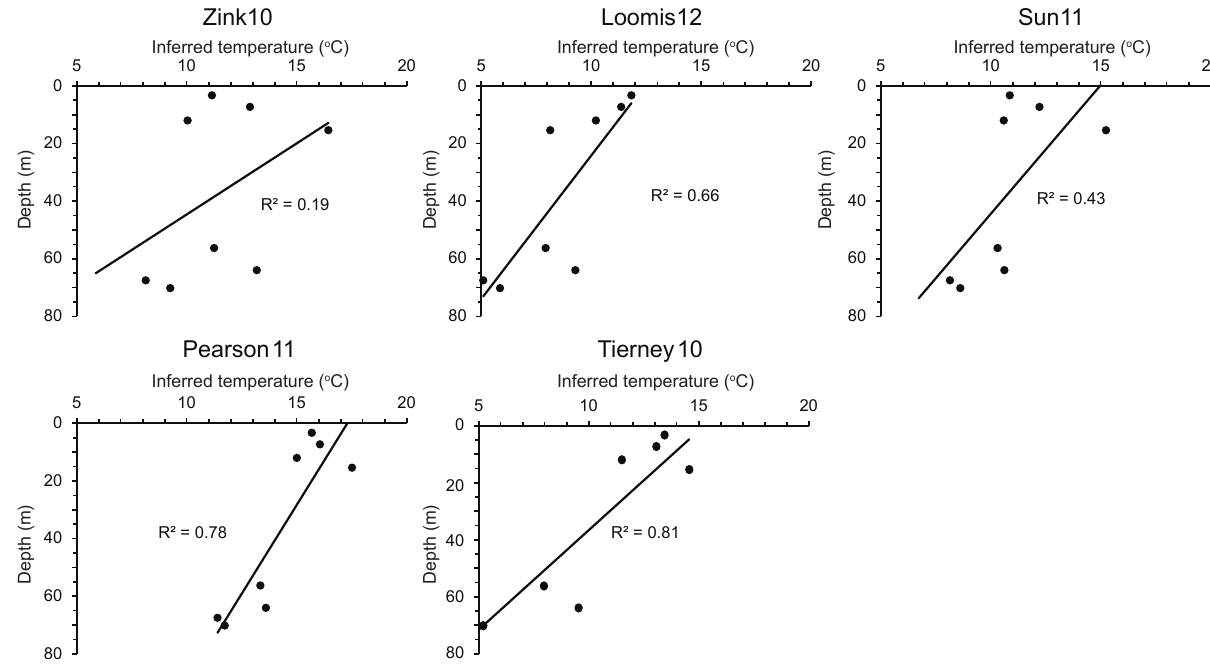
Figure 9. CL-brGDGT-derived MAAT estimates (MSAT in the case of Pearson11) from Loch Lomond surface sediments, against water depth, for the different MBT–CBT lacustrine calibrations (see